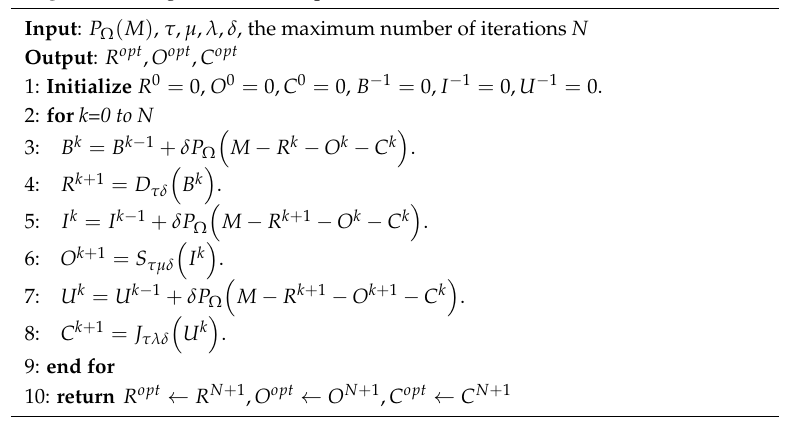
Algorithm 2 Algorithmic description of BDMC